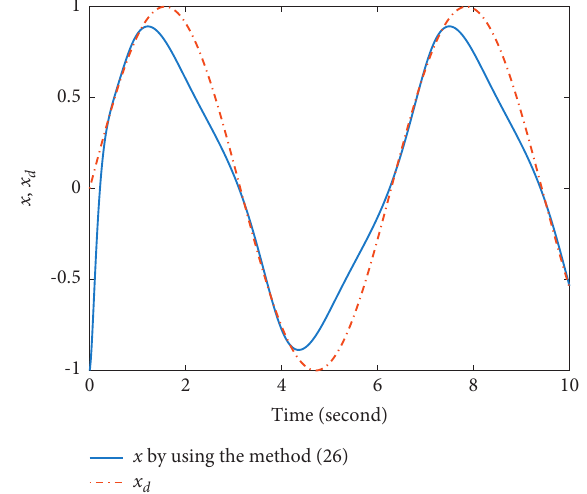
Figure 2: Time response trajectories of x and x (26).